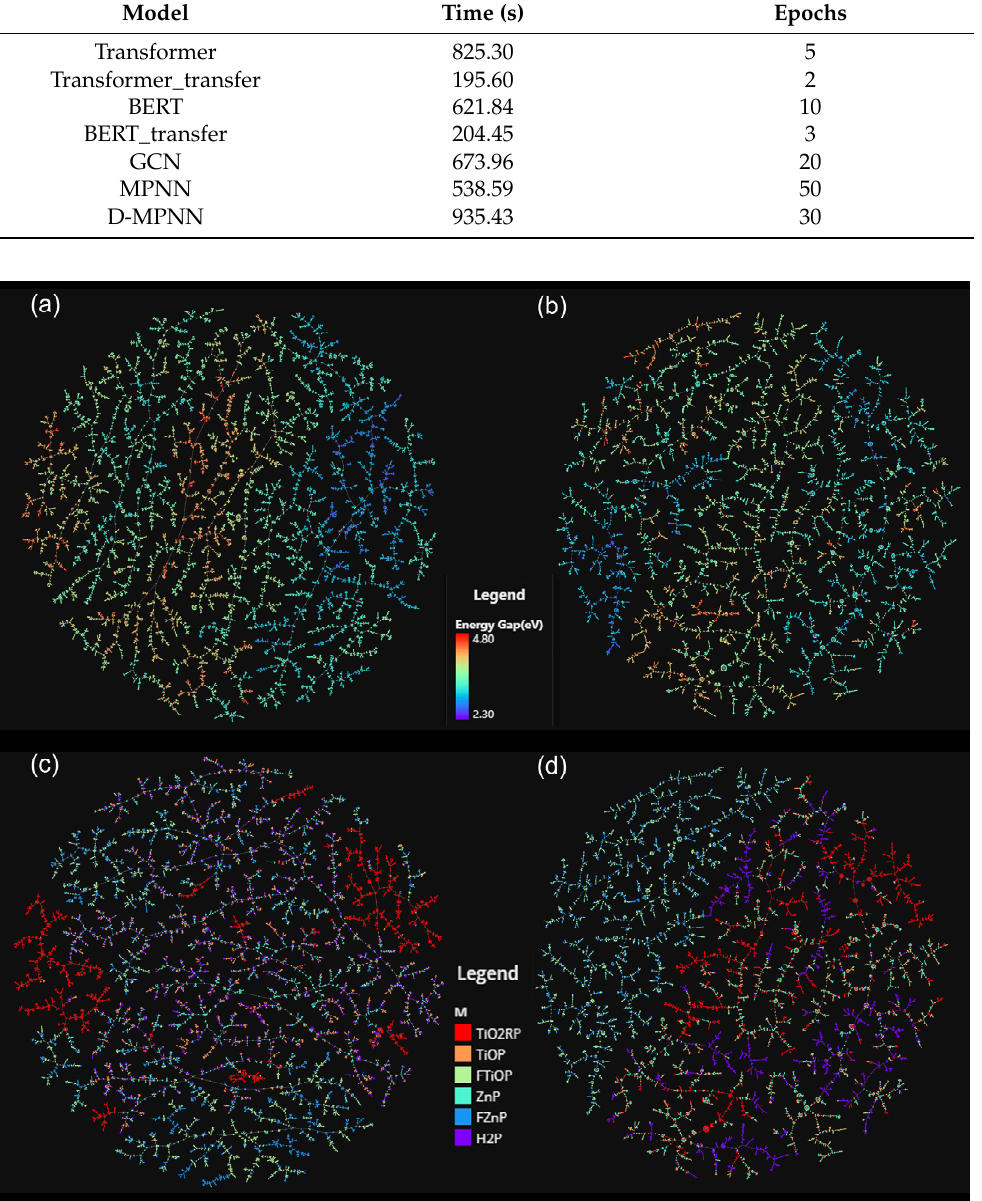
Figure 7. The visualization of chemical space based on the molecular features extracted by the D- MPNN model and BERT model using the TMAP algorithm: ( a ) D-MPNN model, color according to the value of energy gap; ( b ) BERT model, color according to the value of energy gap; ( c ) D-MPNN model, color according to the center metal; ( d ) BERT model, color according to the center metal.